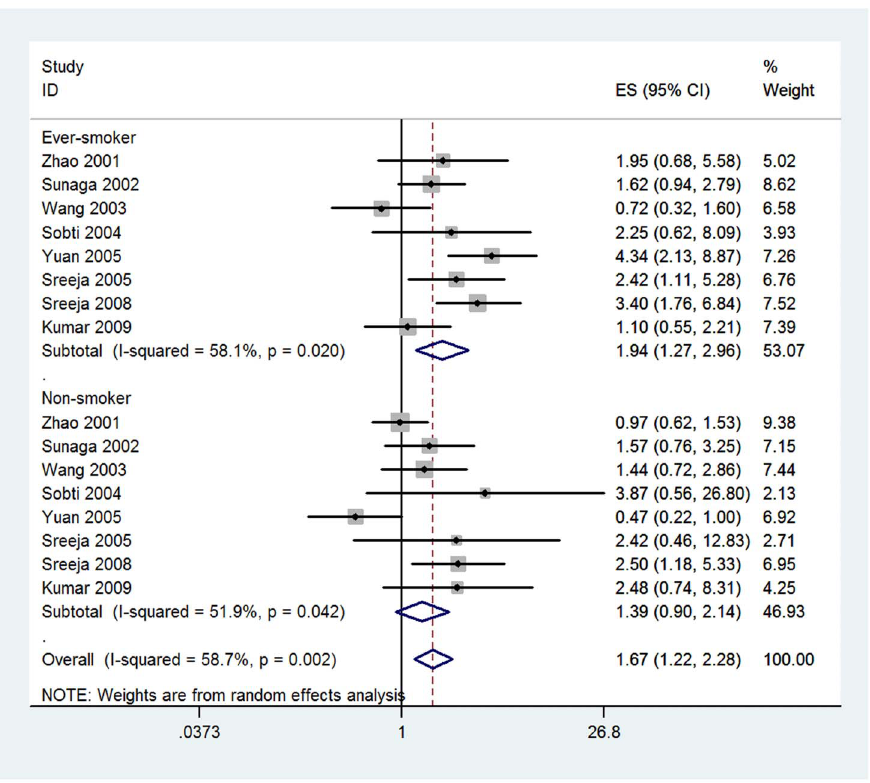
Figure 3. Forest plot for the association between GSTT1 null genotype and lung cancer risk in Asian population on stratification by smoking status.